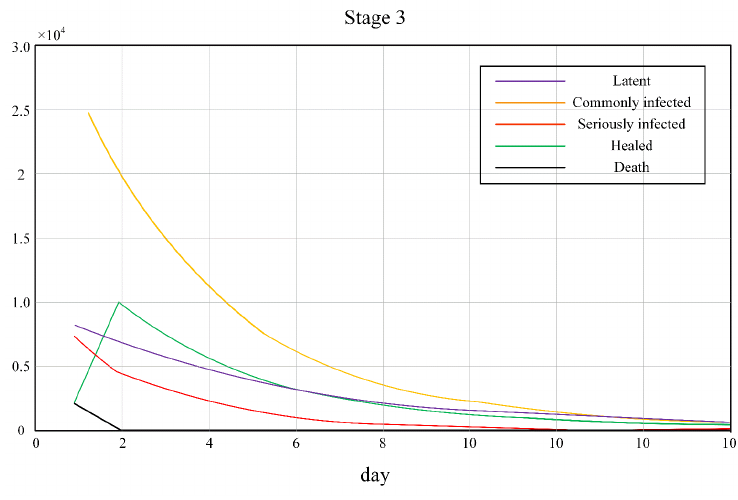
Figure 6. Number of different people in each